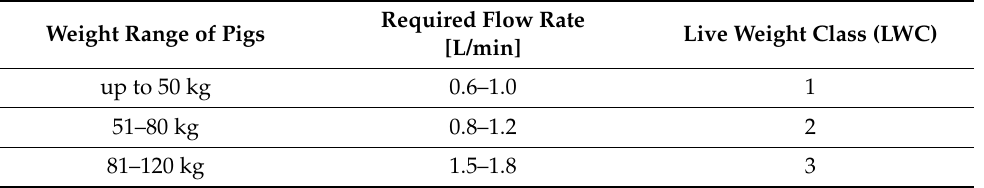
Table 3. Evaluation scheme for flow rates of drinkers according to the KTBL guidelines (according to Schrader et al.